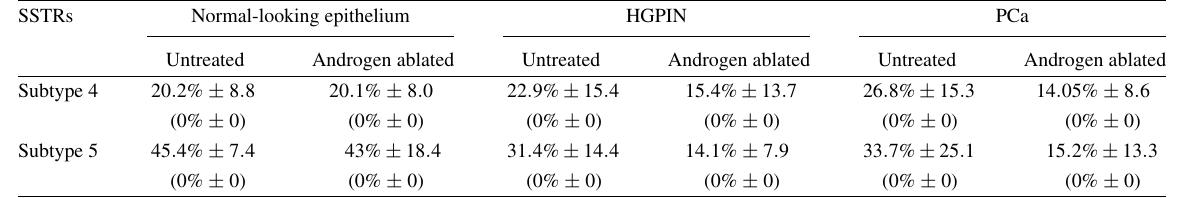
Percentages (mean ± standard deviation) of secretory cells with positive nuclear staining